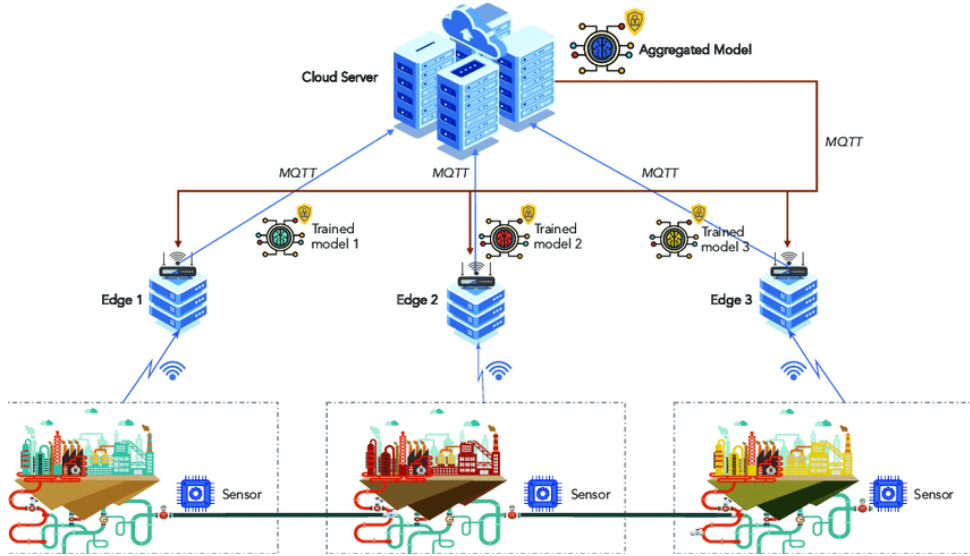
Figure 1. Conceptual View of IoT-Edge-Cloud for Anomaly